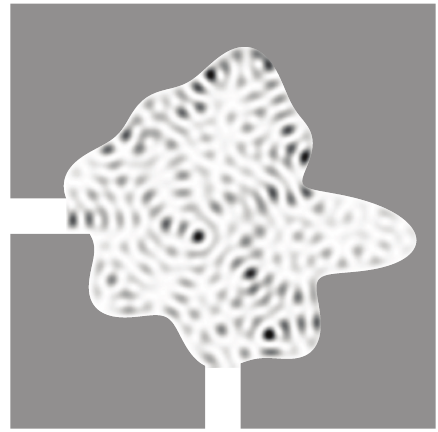
√ 32 π , (cid:4) B = 16.